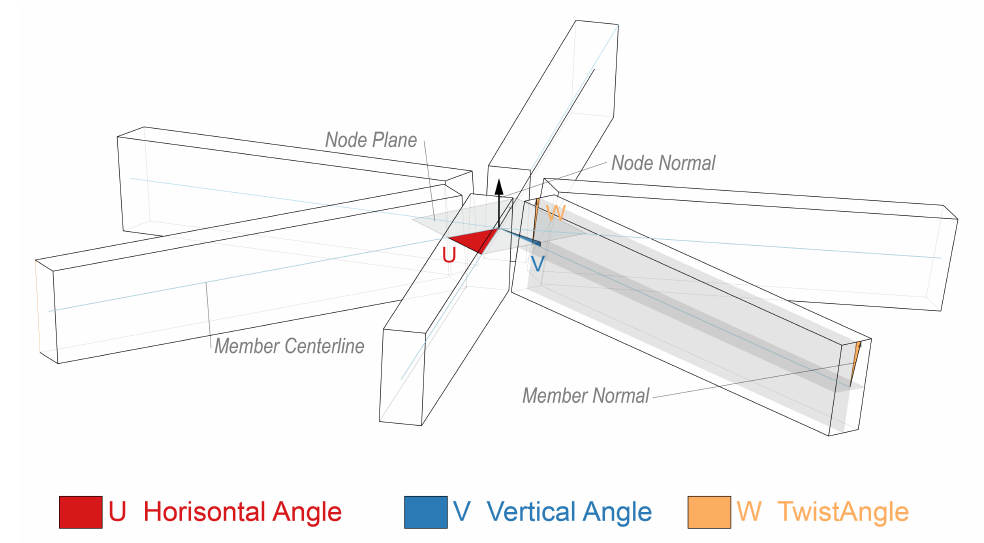
Figure 2. Illustration of the node angles U, V and